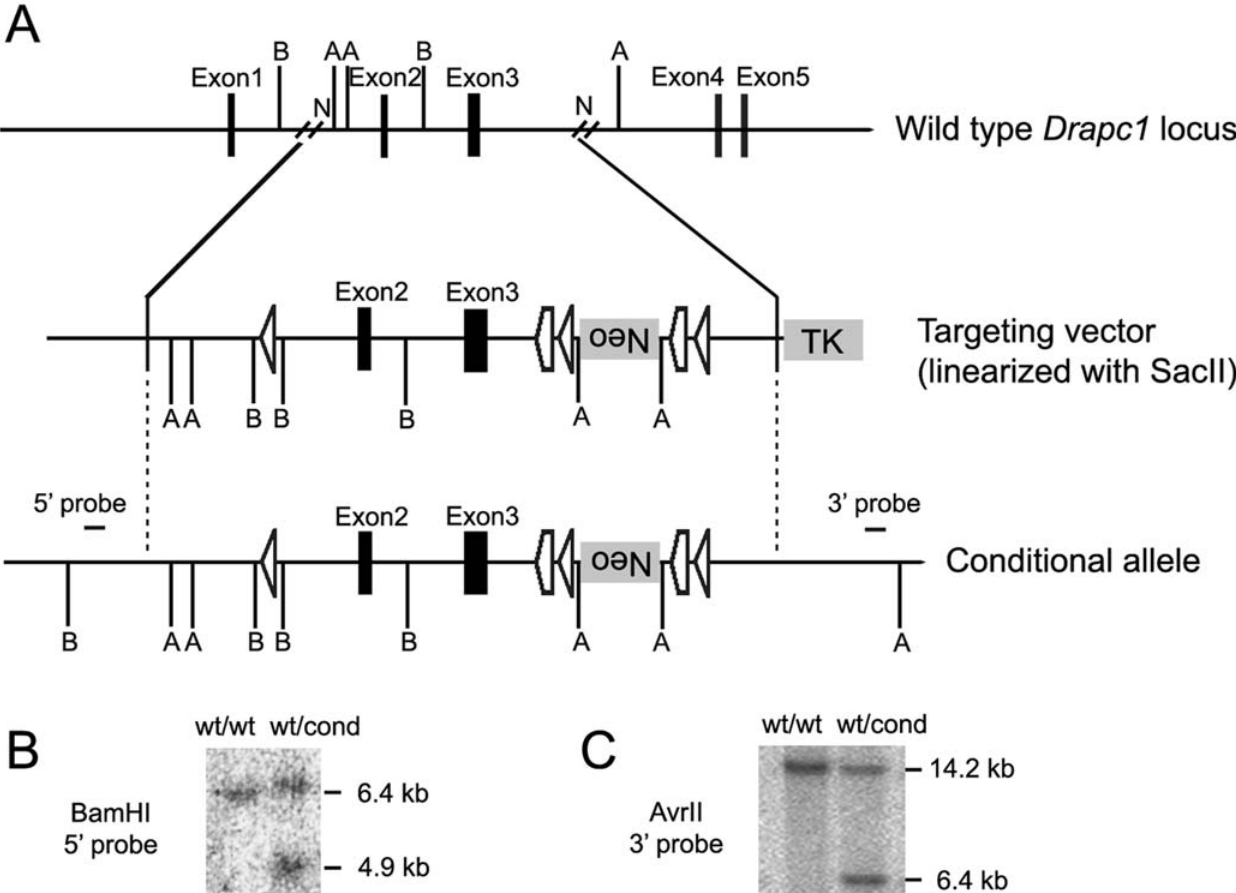
Figure 6. Targeting strategy for the conditional inactivation of the Drapc1 gene. ( A ) Restriction map of the mouse Drapc1 locus, the targeting vector and the targeted allele. Relevant restriction sites: A, AvrII; B, BamHI; N, NsiI. Vertical dotted lines highlight homologous regions. ( B ) Southern analysis of genomic DNA from ES cells (BamHI digestion), with the 5 9 probe illustrating the 6.4 kb wild-type (wt) and 4.9 kb targeted (cond) alleles. ( C ) Southern analysis of genomic DNA from ES cells (AvrII digestion), with the 3 9 probe illustrating the 14.2 kb wild type (wt) and 6.4 kb targeted (cond) alleles.